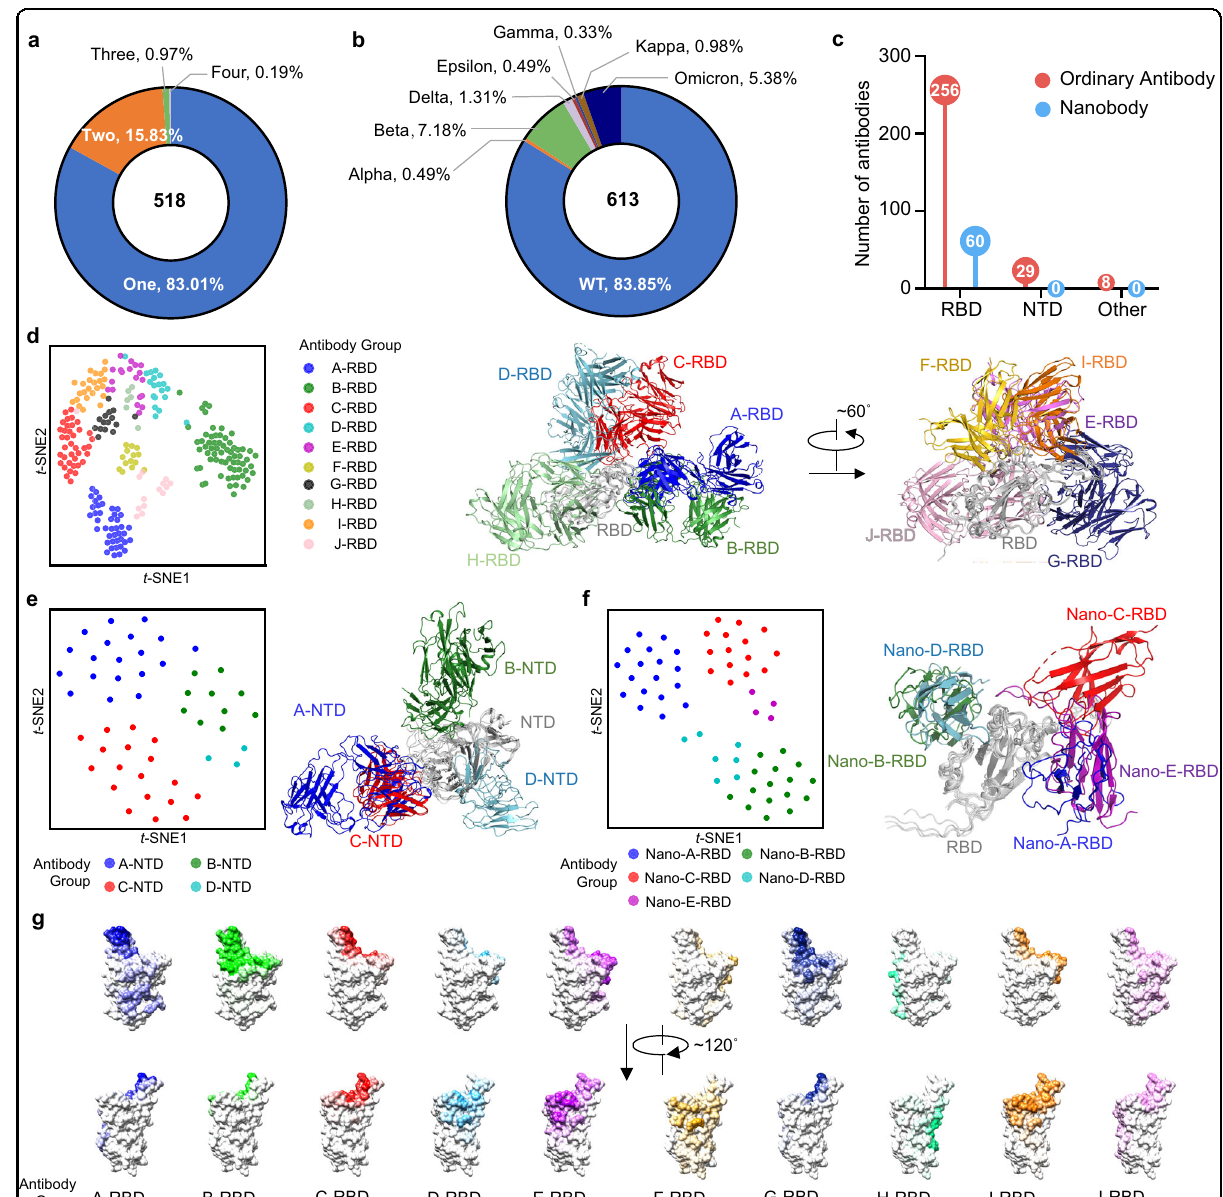
Fig. 1 Antibody landscape of the structure available antibodies against SARS-CoV-2 S protein. a Distribution of the antibody number in the available structures. The antibody and corresponding binding domain are extracted as a subcomplex. Most structures contain only one antibody. b Strain distribution of the S protein in subcomplexes. Most of the S proteins are WT. c Statistics of ordinary antibodies and nanobodies and their corresponding targeting domains in the S protein. d Cluster distribution of the 10 classes of ordinary antibodies targeting RBD, named Ab-A-RBD to Ab-J-RBD, where Ab represents antibody and can be omitted as A-RBD to J-RBD without causing confusion, and structural scheme of the structural classes of some representative RBD antibodies. e is the same as d for 4 classes of NTD antibodies (named Ab-A-NTD to Ab-D-NTD, where Ab represents antibody and can be omitted as A-NTD to D-NTD without causing confusion). f is the same as d for the 5 classes of RBD nanobodies. For the t-SNE analysis of NTD antibodies, all of subcomplexes were used for analysis. For RBD antibodies, only the representative subcomplexes were used. g Epitope distributions of 10 classes of ordinary antibodies targeting RBD. The color depth represents the frequency of the residues as epitopes. The PDB ID for RBD of the S protein is